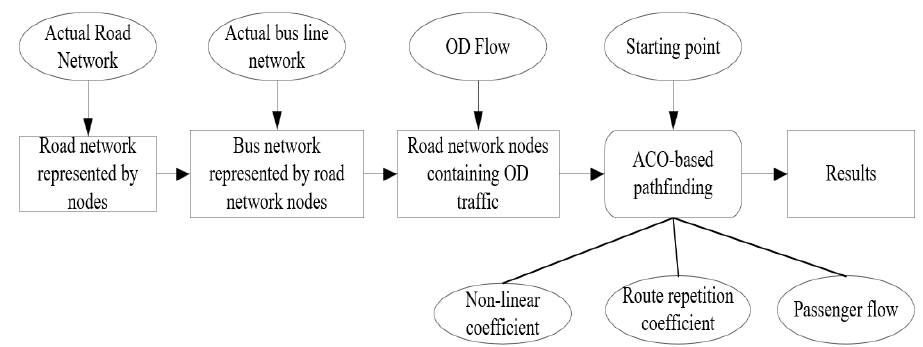
Figure 2. The overall process of bus line network optimization based on ACO.